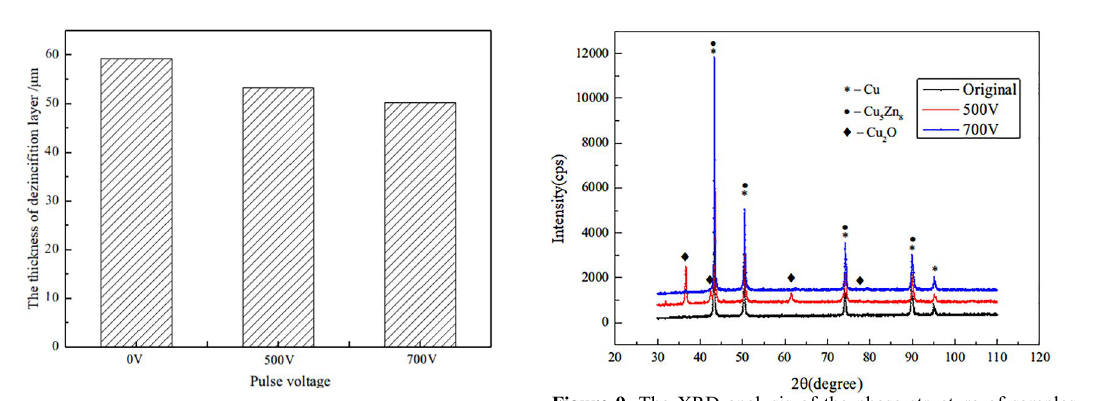
Figure 7. The thickness of dezincification layer of aluminum brass alloy The XRD analysis of the phase structure of samples with and without EPT is given in Figure 8 and Figure 9, respectively, to further explore the internal relations between the changes of the corrosion resistance and phase